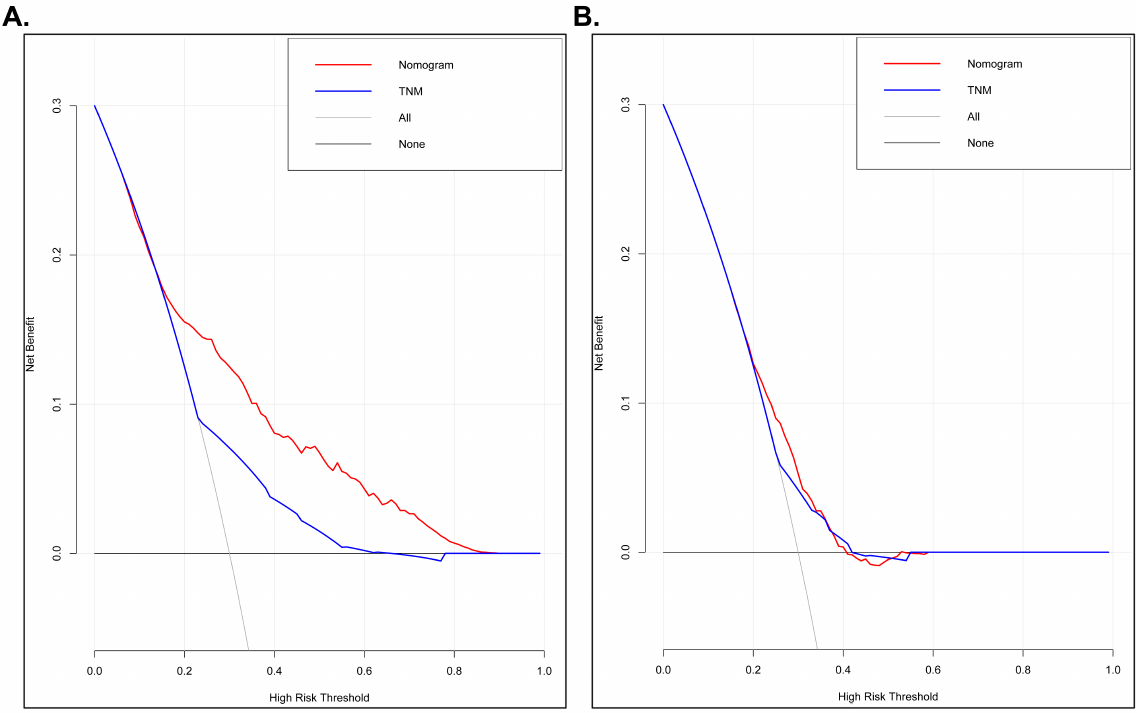
Figure 7 - Decision curve analysis (DCA) based on nomograms and TNM-stage. (A) DCA of OS for patients with bone metastatic RCC; (B) DCA of CSS for patients with bone metastatic